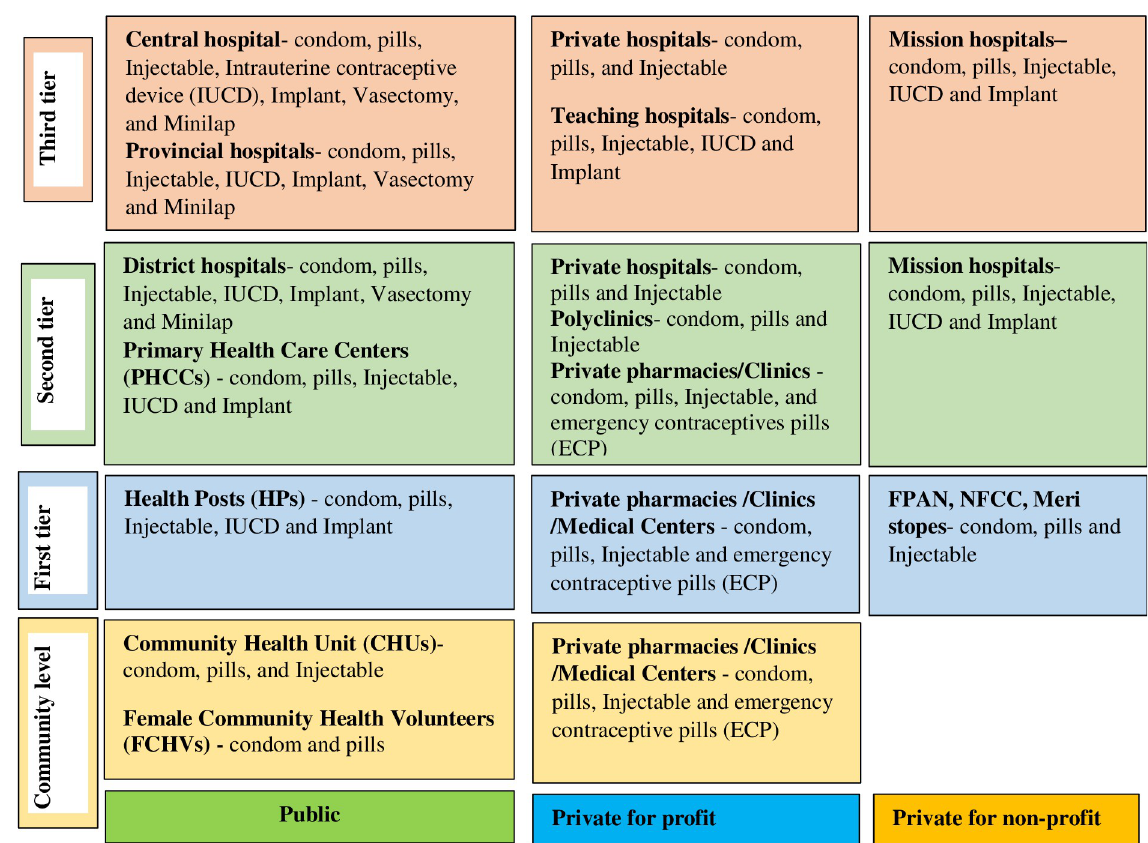
Fig 1. Types and delivery outlets of modern contraceptives in Nepal. Source: Developed by authors based on information obtained from Nepal’s annual health report 2019